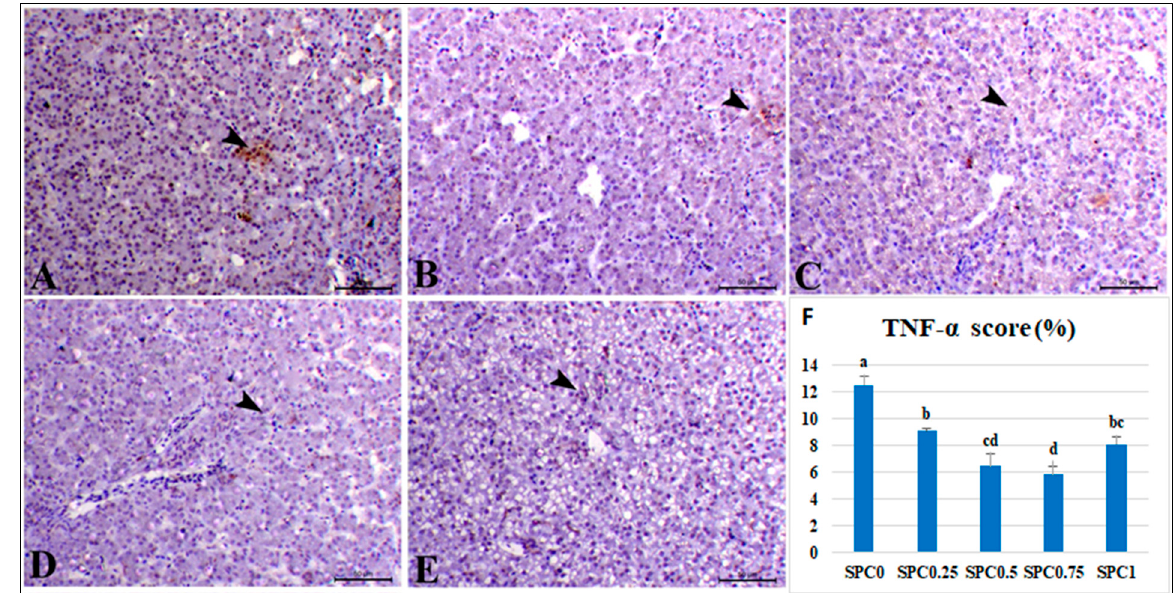
Figure 4. Photomicrograph of hepatic tissues immunostained with TNF- α antibody. The liver of the control SPC0 group showed mild expression of TNF- α within a few hepatocytes ( A ) (arrowhead). The liver of the SPC0.25 group showed scanty expression of TNF- α within hepatocytes ( B ) (arrowheads). The liver of the SPC0.5 group showed a marked decrease in immunostaining of TNF- α within hepatic tissues ( C ) (arrowhead). The liver of the SPC0.75 showed a significant decrease in the expression of TNF- α within the blood sinusoids ( D ) (arrowhead). The liver of SPC1 showed a marked decrease in the expression of TNF- α within hepatocytes ( E ) (arrowhead). Bar = 50 µ m. ( F ) shows morphometric measures of TNF- α immunostaining expression (%). a,b,c,d Means carrying different superscripts were significantly different ( p ≤